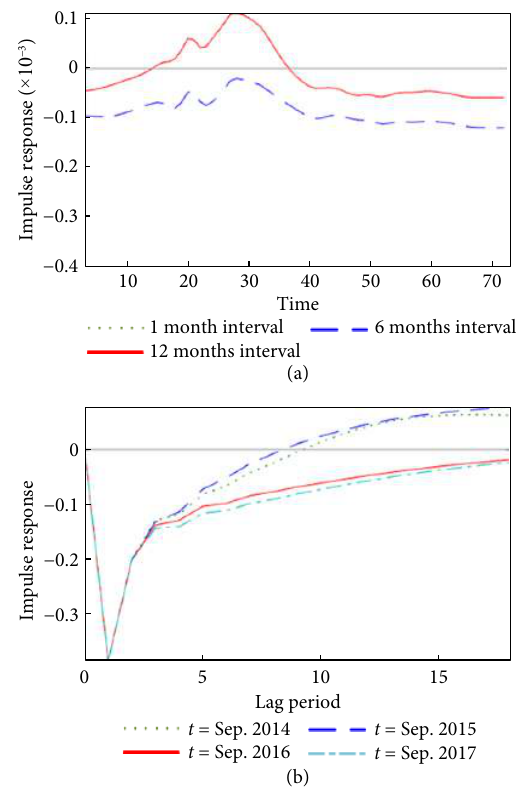
Fig. 7 Equidistant (a) and time-point (b) impulse responses of DTOM to